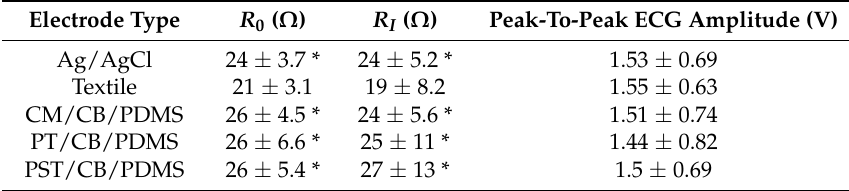
Table 1. Resulting R 0 and R I andpeak-to-peakelectrocardiogram(ECG)amplitudesforinter-subjectanalysis.